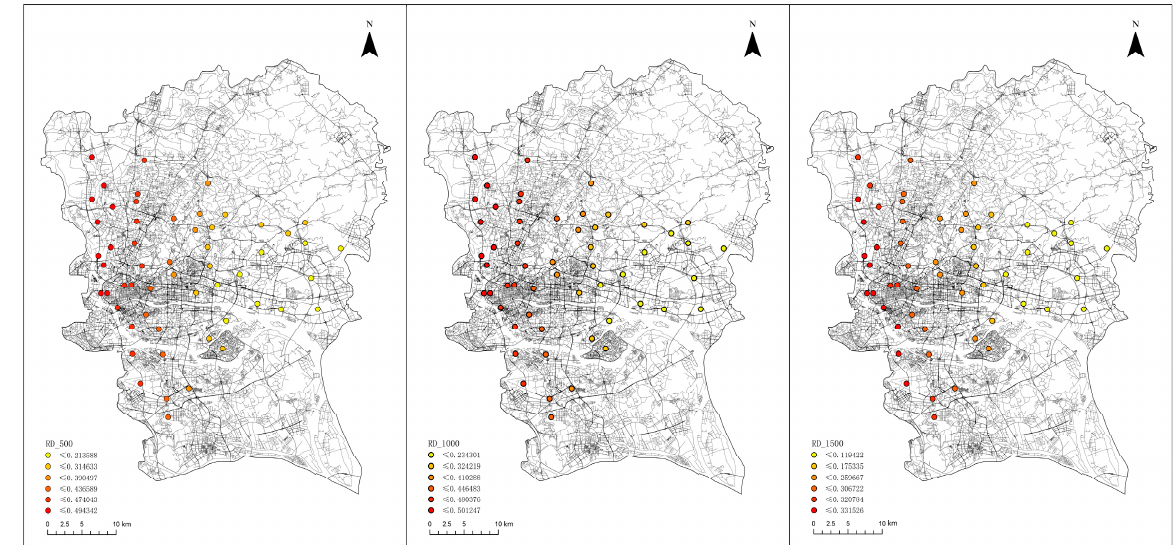
Figure 6. Spatial patterns of coefficients in the multi-scale geographically weighted regression analysis for road density (RD).